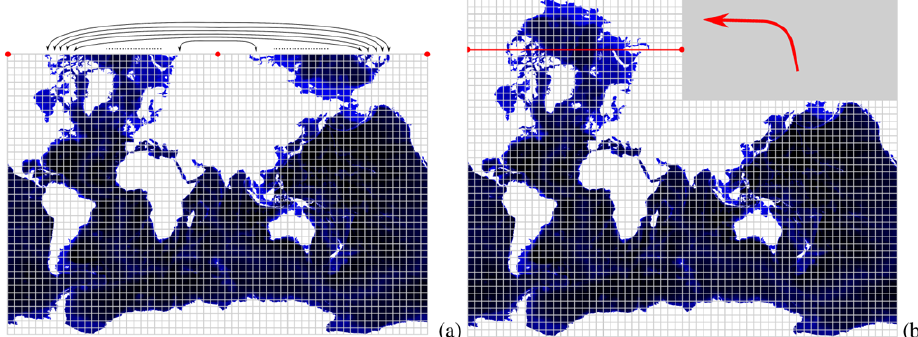
Fig. 5. (a) A subdivision of the topography into 60 × 40 blocks. The two tripoles are depicted by the red dots on the upper boundary. Note that the leftmost and rightmost dots represent the same tripole; the tripole communication is (partially) shown by the arrows. (b) A remapping of the grid that moves an area of 30 × 7 blocks. The original tripole boundary is shown as a red line.